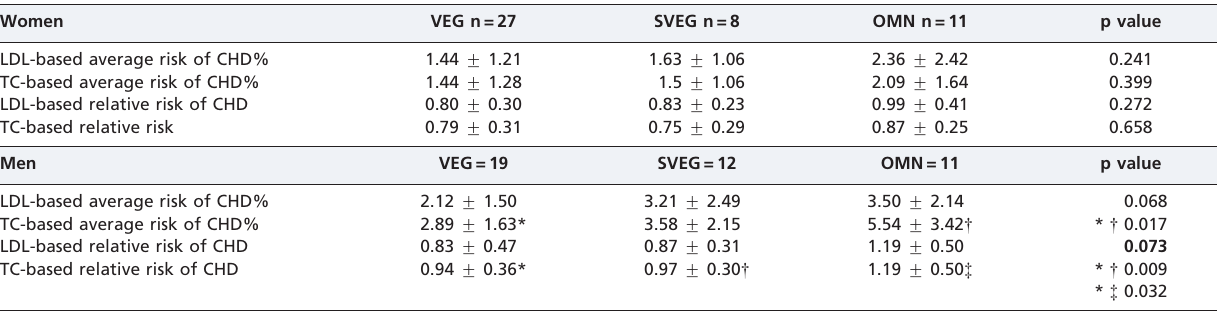
* LDL-based average risk=average risk calculated from LDL categories; TC-based average risk=average risk calculated from total cholesterol categories; LDL-based relative risk=relative risk calculated from LDL categories; TC-based relative risk=relative risk calculated from total cholesterol categories; CHD=coronary heart disease. Means and percentages with different signs are significantly different from each other; p , 0.05 (Scheffe’s test for ANOVA for means and Fisher’s exact test for percentages). VEG=vegetarians, SVEG=semi-vegetarians,